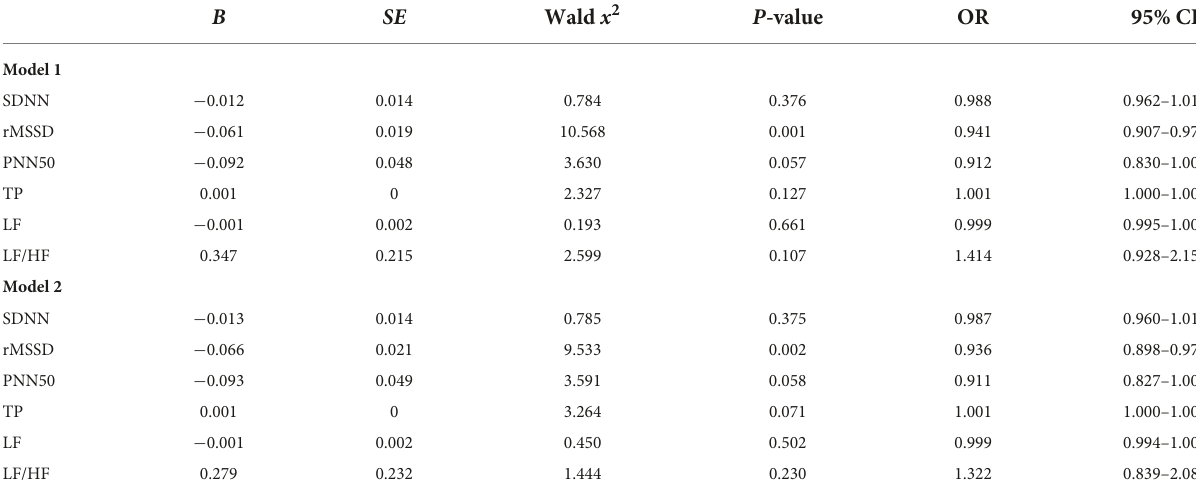
TABLE 4 Heart rate variability (HRV) in relation to cognitive impairment in patients with enlarged perivascular space (EPVS) (binary logistic